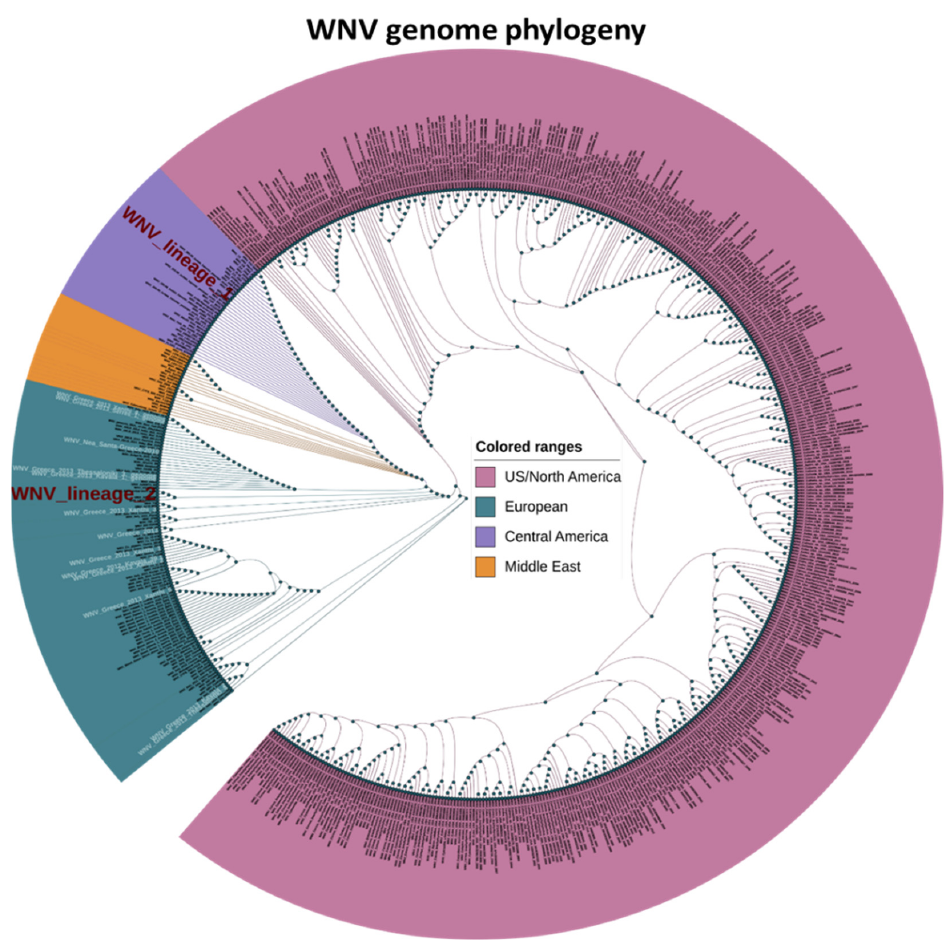
Figure 1. Phylogenetic analysis of WNV Maximum-likelihood phylogenetic tree analysis of 616 genomic sequences from a global collection of WNV isolated strains. Thirteen sequences from Greece are highlighted in white. All strains are coloured according to collection origin. The reference strains of WNV lineage 1 and 2 are also shown in red.